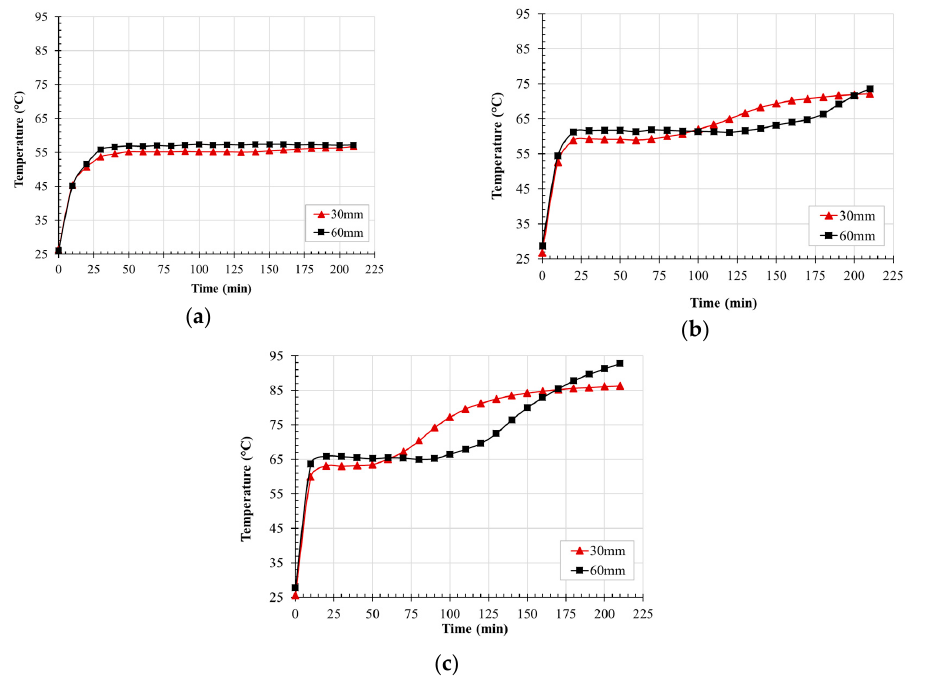
Figure 9. Heat sink surface temperature using RT47 for different thicknesses at power ratings ( a ) 1.0 W, ( b ) 1.5 W and ( c ) 2.0 W.